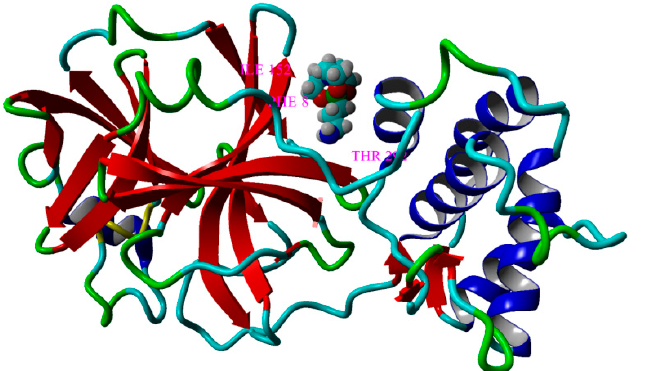
Figure 10. Molecular rendering of the best docked pose showing the interaction between M PRO receptor (COVID-19 main protease) and silatrane SIL M.